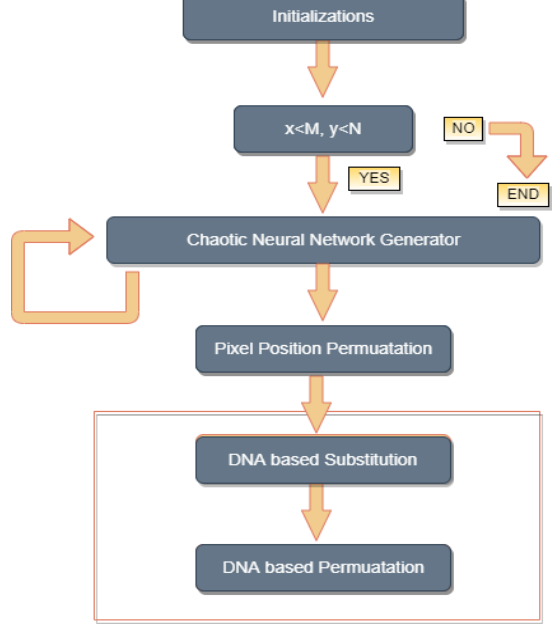
Figure 3. Neural network-based generator architecture.